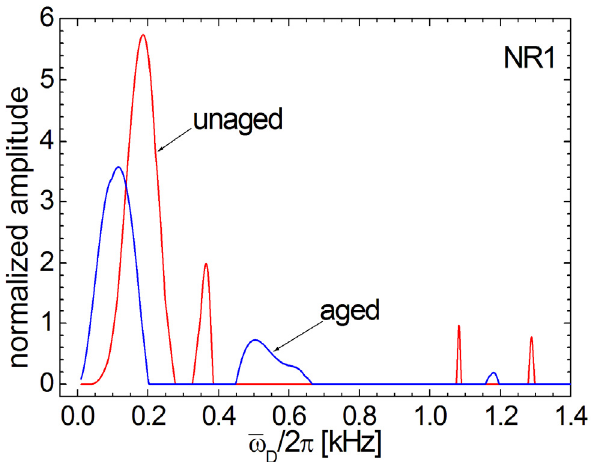
Figure 11. Comparison between 1 H DQ Laplace-like spectra for the six-years aged (gray line) and unaged (black line) NR1 natural rubber sample. The distributions were renormalized in order to have the same integral area.